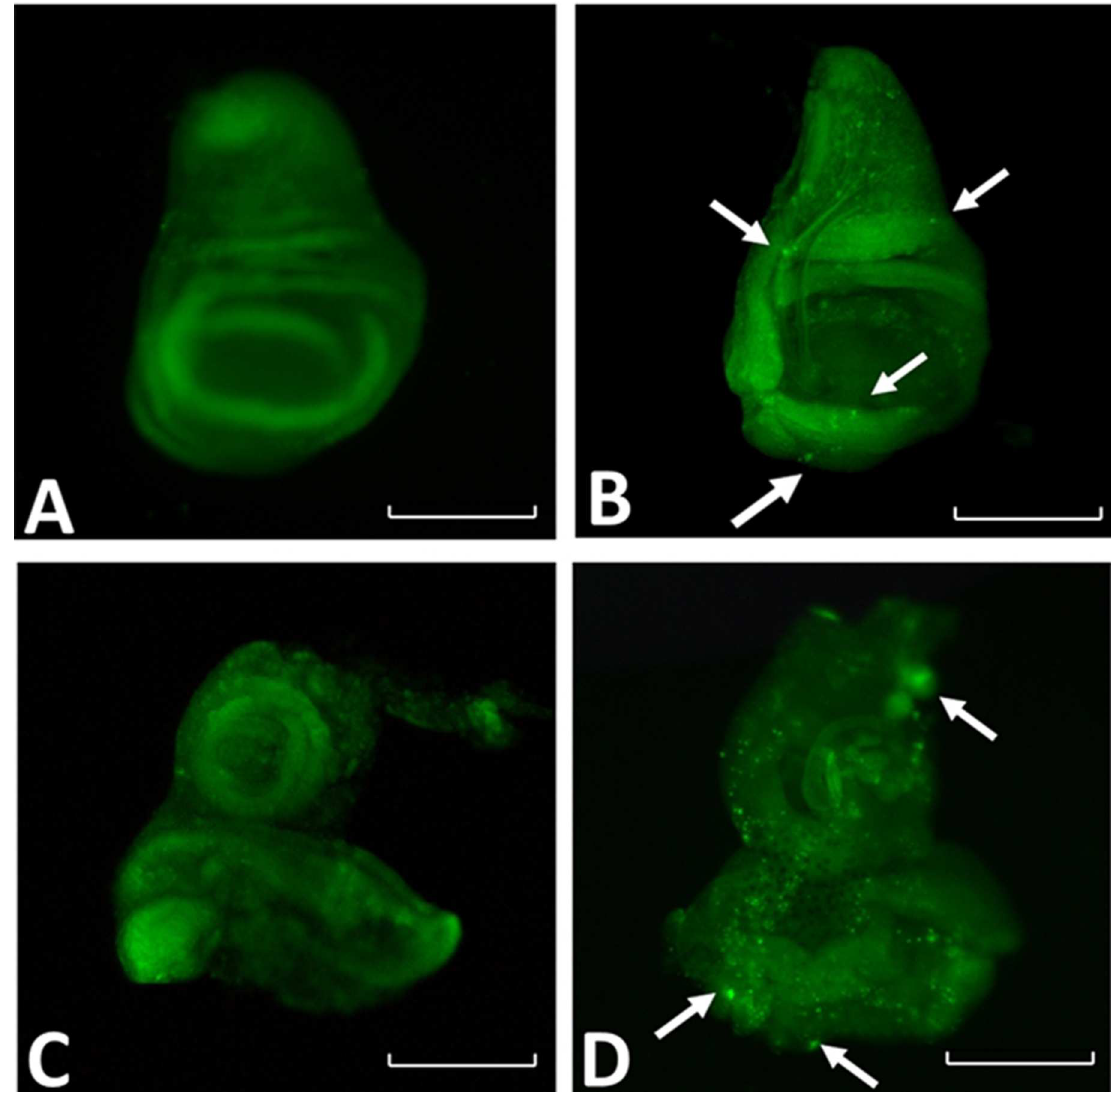
Fig 6. Expression of RpPax6 promotes apoptotic cells were identified by acridine orange staining. Arrow points to a cluster of apoptotic cells. All discs are reproducedat the same magnification. Scale bars = 100 μ m. (A) Third instar wing disc of UAS-RpPax6/da-GAL4 , tub-GAL80 ts reared continuously at 18˚C exhibitno cell death as indicatedby a lack of nuclear acridine orangestaining. (B) Expression of RpPax6 for 24 h ( UAS-RpPax6/da-GAL4 , tub-GAL80 ts , shifted to 29˚C) lead to cell death in third instar wing disc as indicatedby nuclearacridineorangestaining (green spots). (C) Third instar of eye-antennadiscs of UAS-RpPax6/da-GAL4 , tub-GAL80 ts reared continuously at 18˚C show a few cell death. (D) Expression of RpPax6 for 24 h ( UAS-RpPax6/da-GAL4 , tub-GAL80 ts , shifted to 29˚C) lead to high frequencyof apoptoticcells in third instar eye-antenna